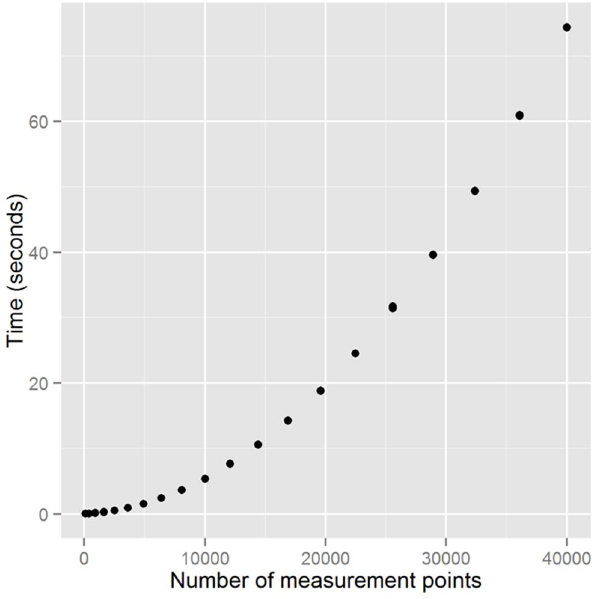
Figure 6. Relationship between the computation time and the number of measurement points for